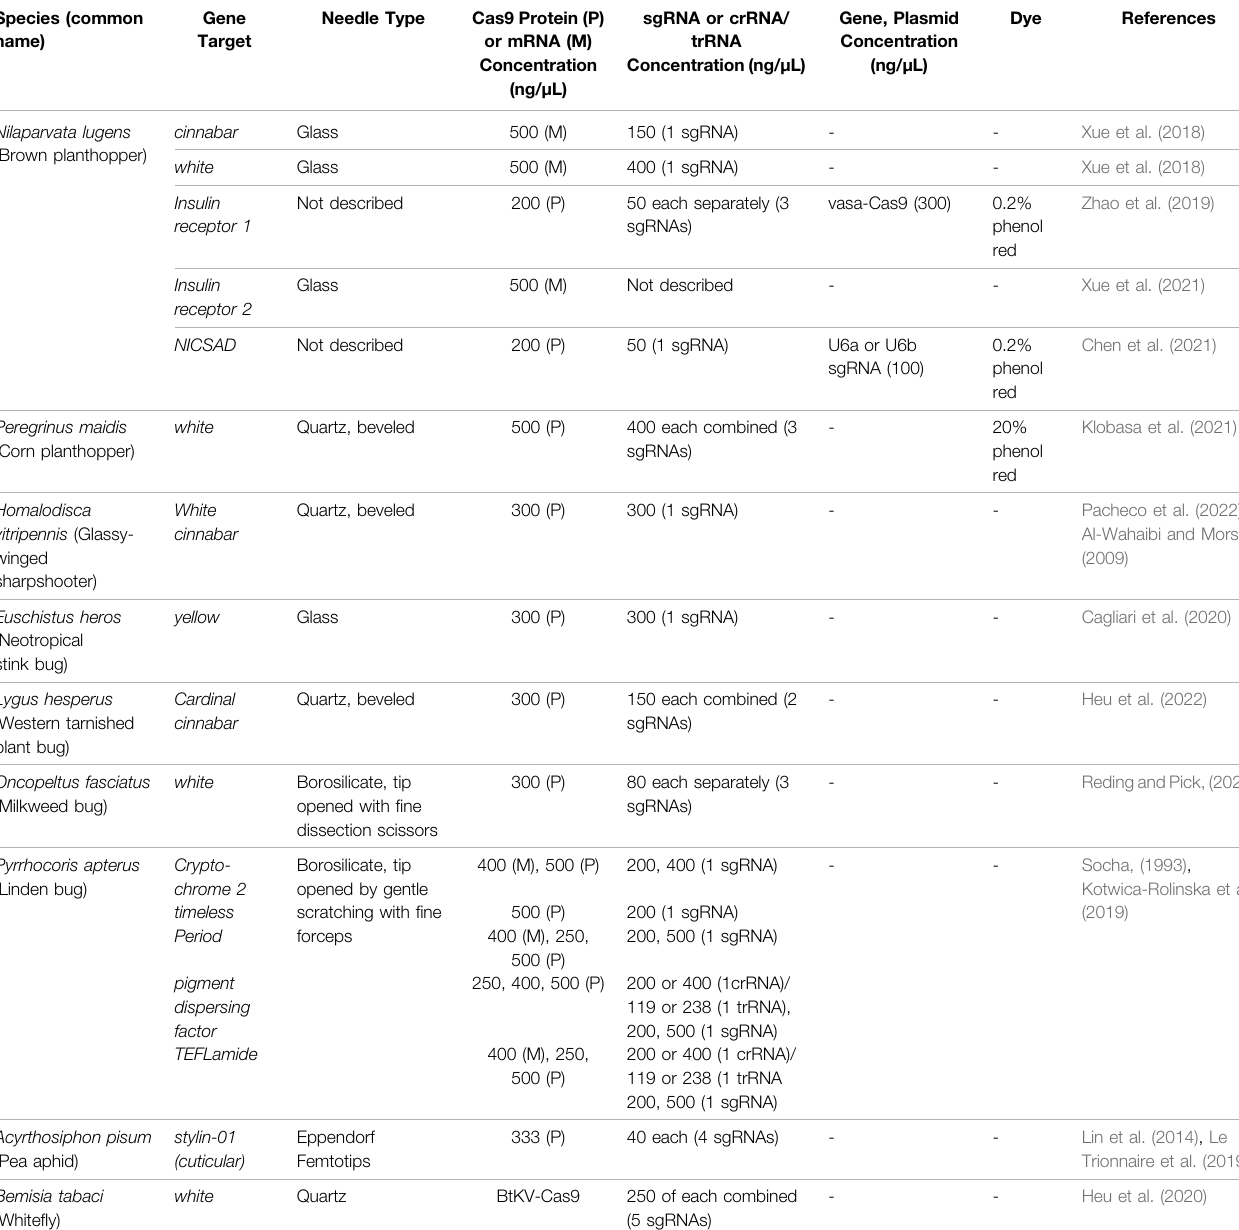
TABLE 3 | Microinjection protocols of CRISPR/Cas9-mediated mutagenesis in Hemiptera. Species (common